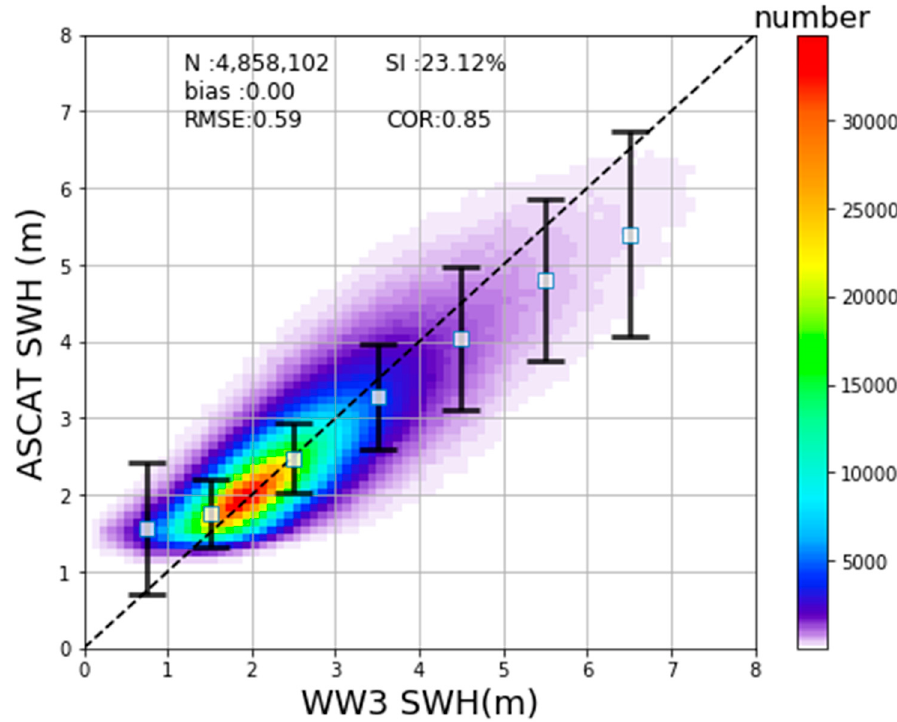
Figure 6. Significant wave heights estimated from ASCAT via the deep learning network versus WW3 hindcast data (from test dataset). Colors denote the data point numbers within 0.1 m × 0.1 m bins.